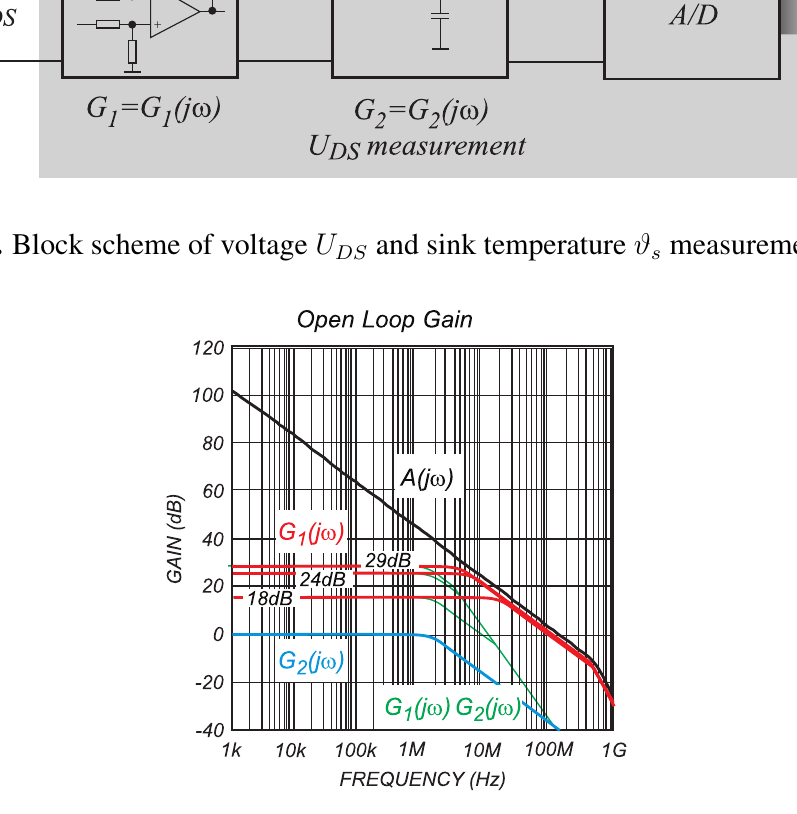
Figure 11. Frequency characteristic of open-loop gain for LMH6611 (black line), closed-loop gains (red lines) and whole measurement chain (tiny green